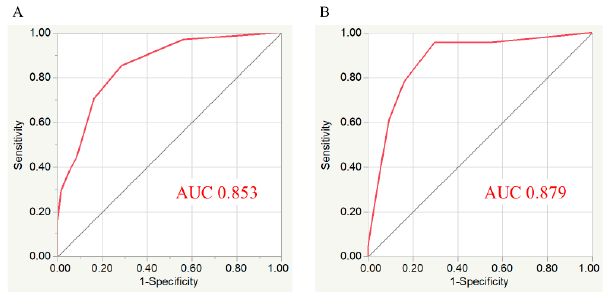
Figure 3. Risk stratification for predicting in-hospital mortality. ( A ) derivation cohort and ( B ) validation cohort. The low-, moderate-, and high-risk groups have scores assigned as follows: 0–1, 2–4, and ≥ 5, respectively.